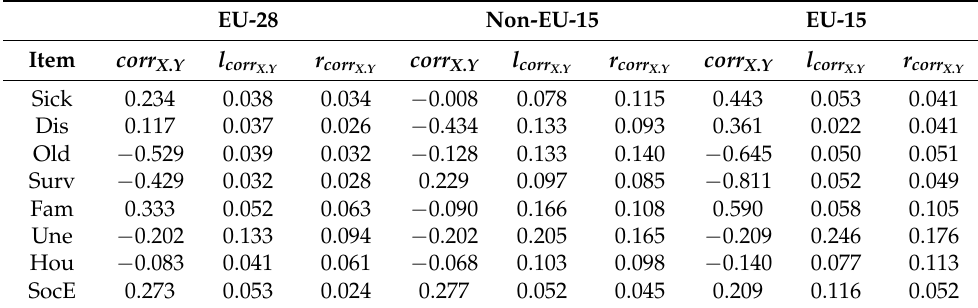
Table 13. Value of the correlations between DF and the proportion that each kind of social expense suppose in overall SER. EU-28